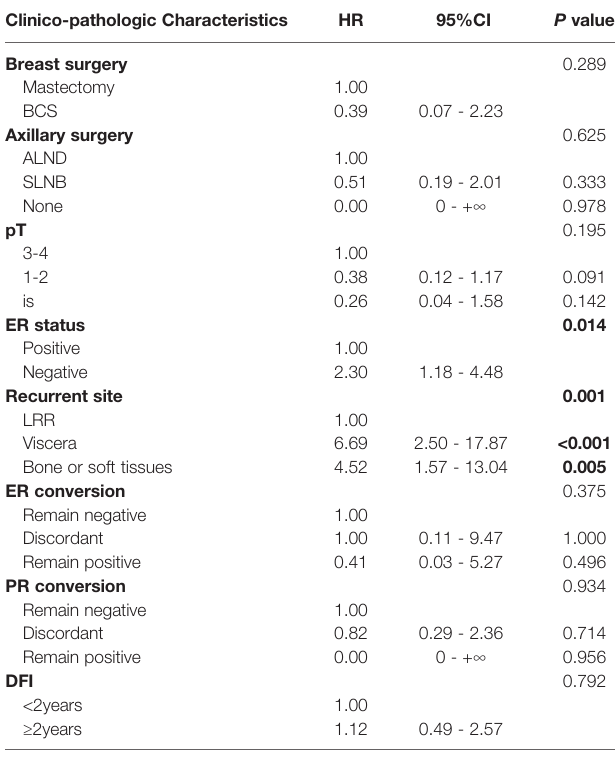
FIGURE 2 | Post-recurrence survival in breast cancer patients according to (A) ER conversion and (B) PR conversion. ER, estrogen receptor; PR, progesterone receptor.